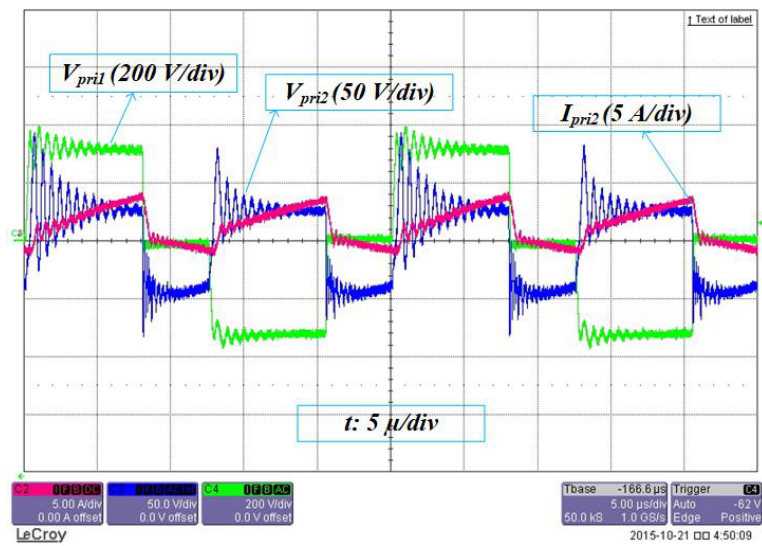
Figure 14. Voltage and current of transformer 𝑇𝑅 2 at 100% of load.